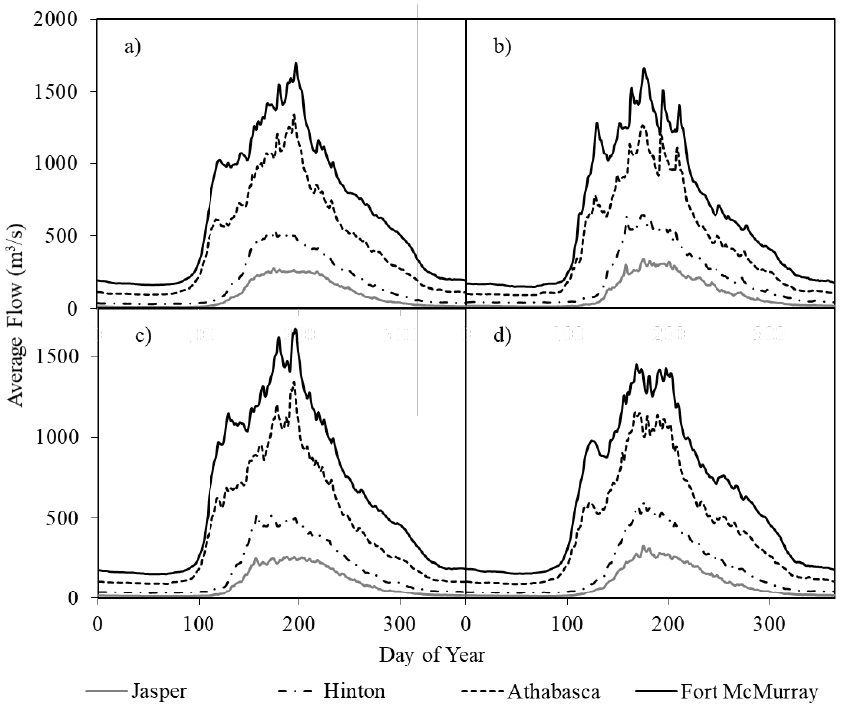
Figure 4. Average daily river flow at each gauging station during the period: ( a ) 1971 – 2000; ( b ) 2001 – 2014; ( c ) 1971 – 2014, odd years; and ( d ) 1971 – 2014, even years. ( a ) and ( b ) are the calibration and validation data for Approach 1, respectively; ( c ) and ( d ) are the calibration and validation data for Approach 2, respectively.